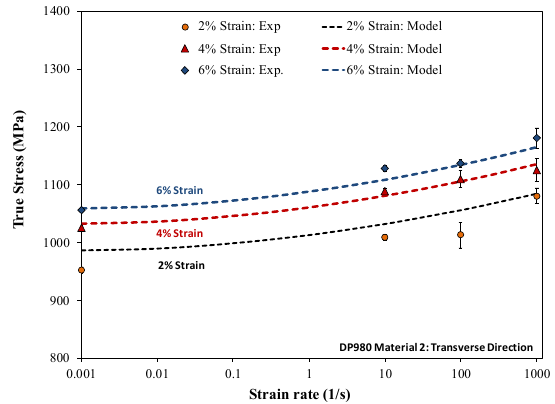
Fig. 18. Experimental rate sensitivity of Material 2 compared to the CS model predictions.